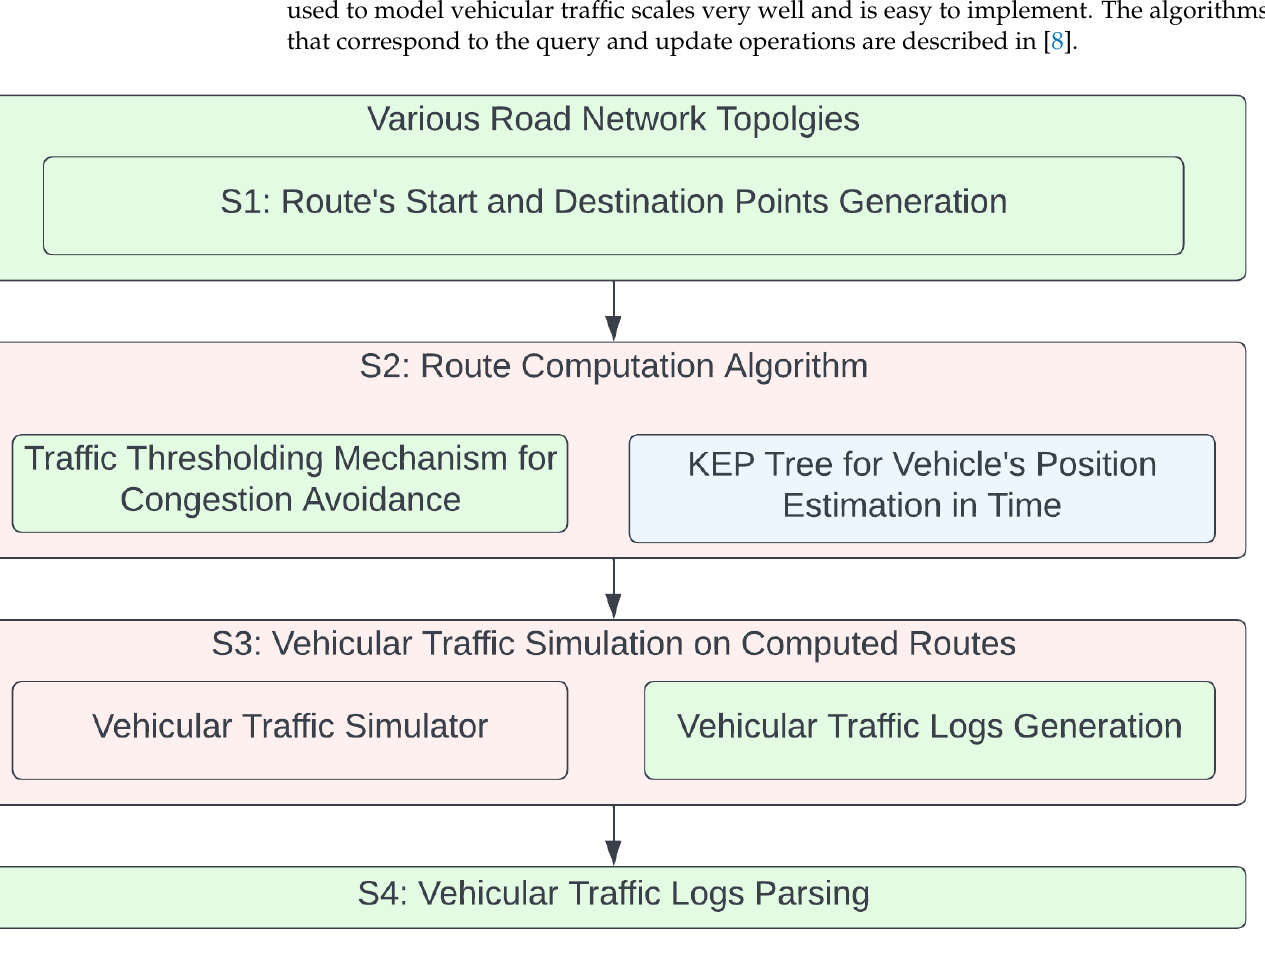
Figure 2. Flow diagram of vehicular traffic congestion avoidance